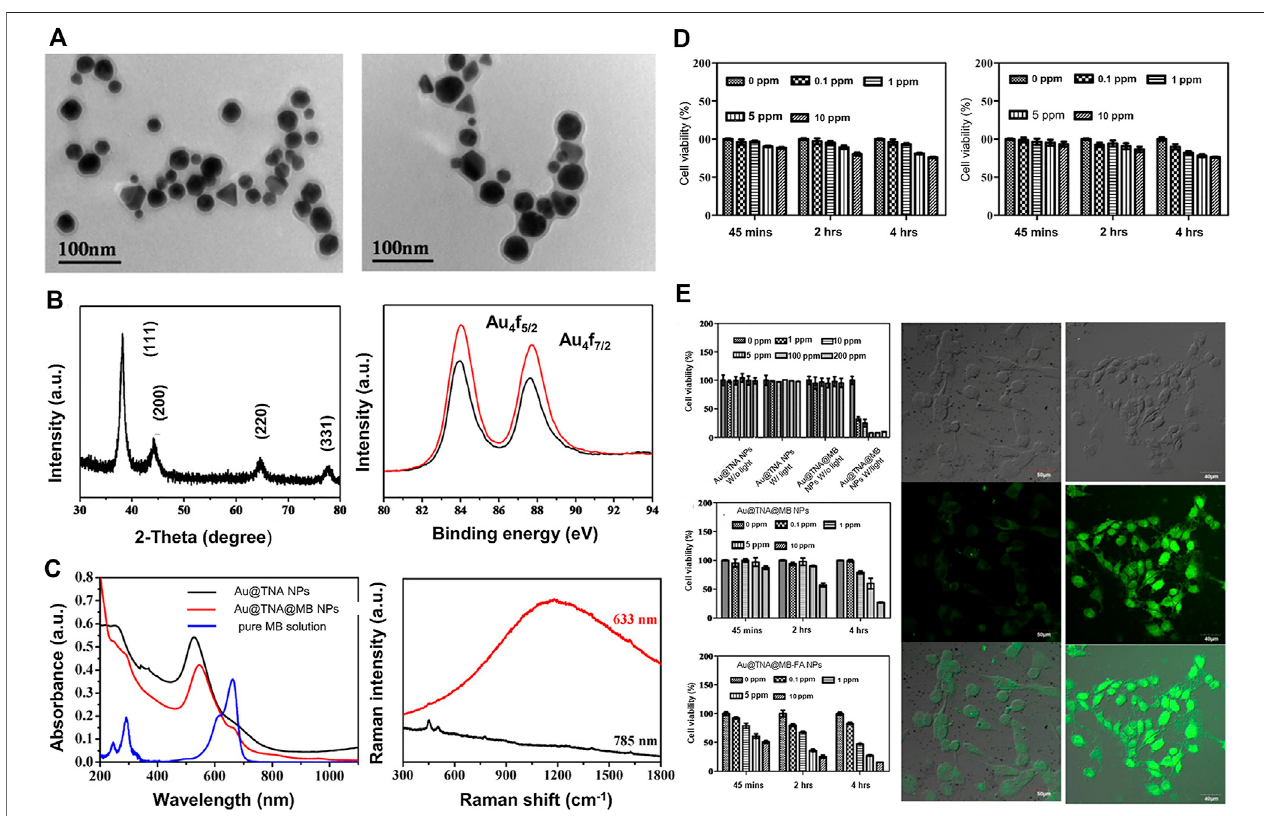
FIGURE 5 | FA-conjugated Au@TNA@MB NPs for enhanced PDT therapy of BC cells. (A) Transmission electron microscopy (TEM) images of Au@TNA NPs and Au@TNA@MB NPs. (B) X-ray diffraction patterns of Au@TNA@MB NPs and X-ray photoelectron spectroscopy of two nanoparticle types. (C) UV-visible and fl uorescence spectra of two types of NPs and Raman spectra of Au@TNA@MB NPs under different excitation wavelengths. (D) MTT assay at different time-points after treatment of SV-HUC-1 with two nanoparticle types. (E) MTT assay of T24 cells treated with nanoparticles under different conditions for 24 h. Photodynamic therapy of T24 cells treated with different nanoparticles stained with DCFH-DA dye. Reproduced with permission from (Hsu et al., 2020).